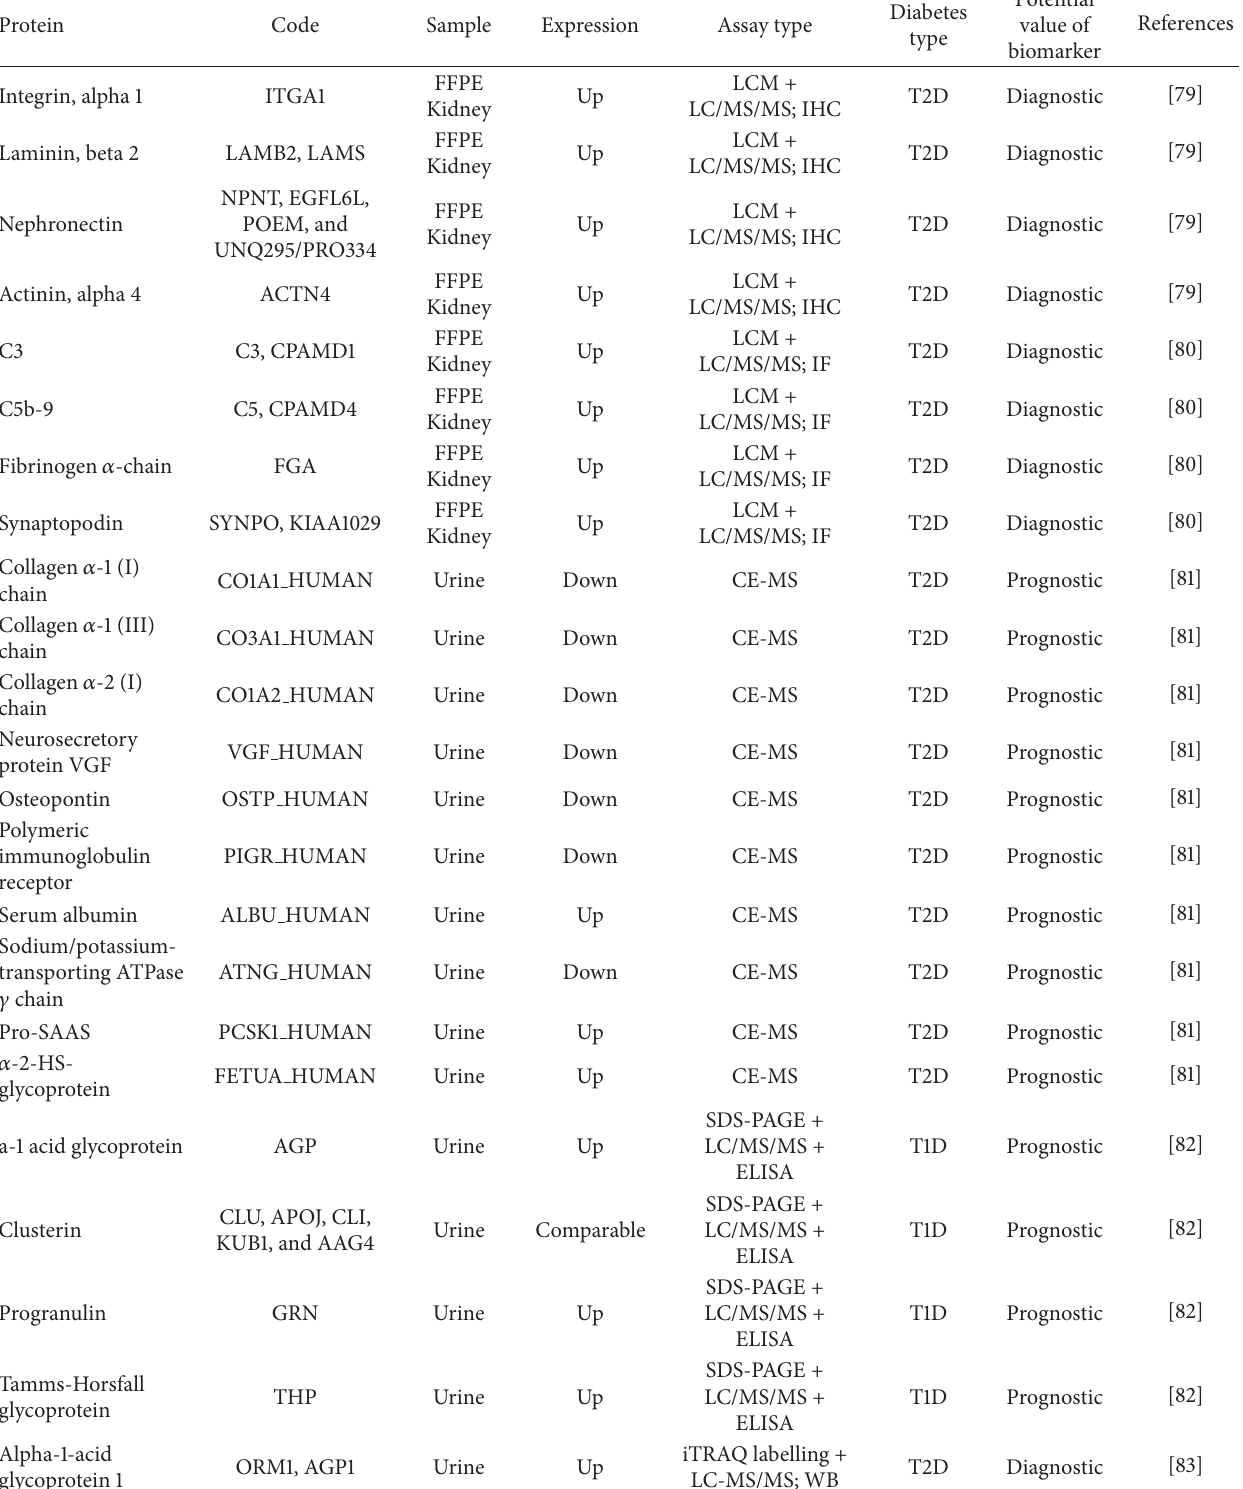
Table 5: Proteomic biomarkers. List of significant protein biomarkers ordered as they are cited in the text. LCM: Laser Capture Microdissection; LC/MS/MS: liquid chromatography coupled to tandem mass spectrometry; IF: immunofluorescence; IHC: immunohis- tochemistry; SELDI-TOF/MS: Surface Enhanced Laser Desorption Ionization Mass Spectrometry; CE-MS: capillary electrophoresis; 2DE: two-dimensional